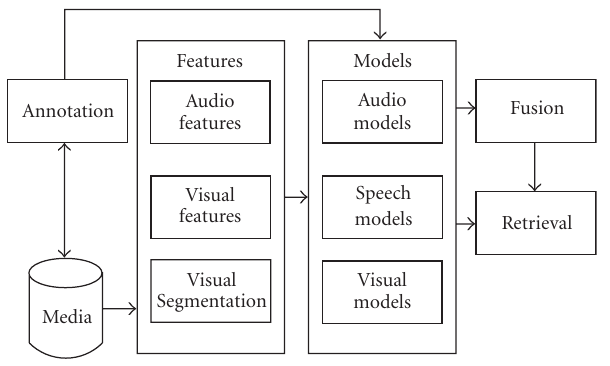
Figure 1: Diagram of semantic-concept analysis